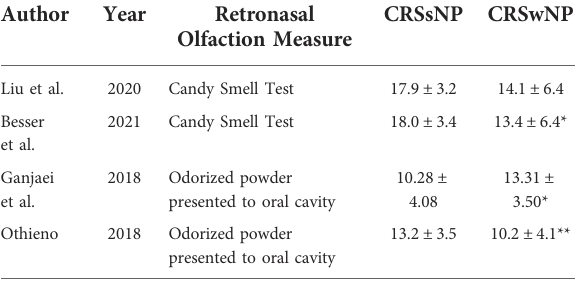
TABLE 2 Retronasal olfactory test scores by CRS subtypes.